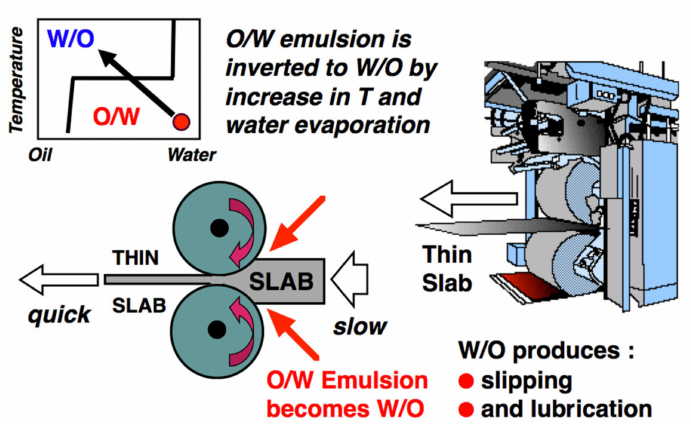
Figure 23. Schematic of O/W emulsion formulation and application for high-performance